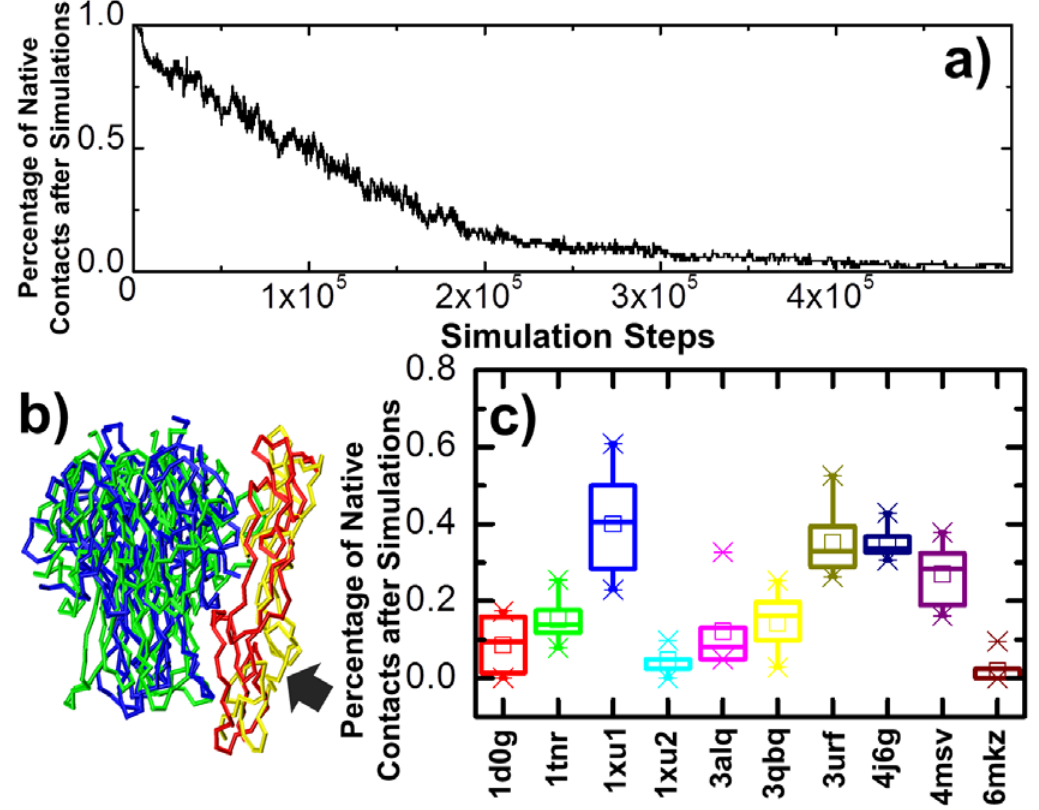
Figure 4. The coarse-grained Brownian dynamic simulations were carried out to compare the dissociation processes among all the 10 protein complexes in the dataset. We carried out 10 independent simulation trajectories for each complex from its native structural conformation. For each trajectory, we calculated the percentage of native contacts left in the dissociating complex along with the simulation time. The changes of this percentage in one of these trajectories is shown in ( a ) as a function of time for the complex LT α / TNFR1. The comparison between initial and final conformations of this specific trajectory is further shown in ( b ). The region with the largest structural variations in the receptor is highlighted by an arrow. Finally, the statistical distributions of native contact percentage remaining after simulations calculated from all 10 trajectories are plotted as a box-whisker diagram in ( c ) for all the complexes, wherein protein databank (PDB) IDs are indexed at the bottom. In the diagram, the average values of percentage are marked as small squares in the middle of each distribution, whereas the maximal and minimal values are marked as symbols of snowflakes. The box of each distribution in the plot indicates the range from 25 to 75 percentiles, whereas the whisker indicates the outlier of the distribution with the coe ffi cient equal to